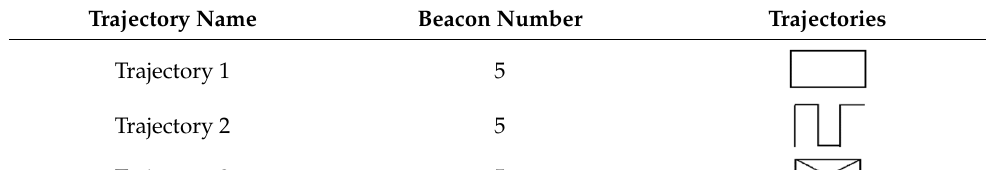
Table 1. Trajectories.